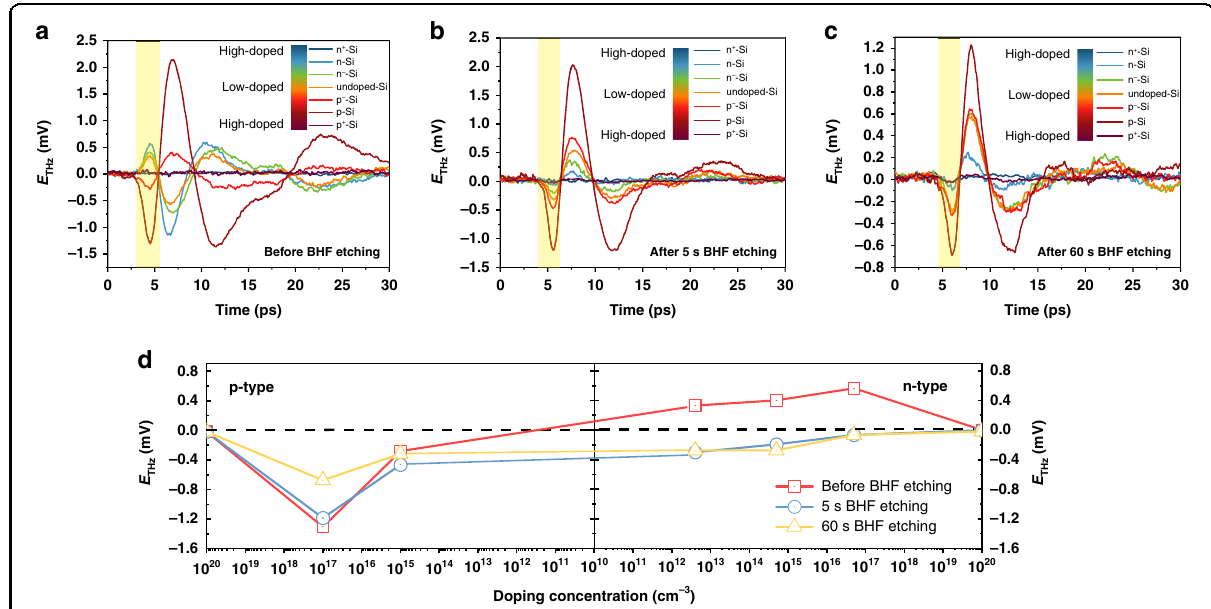
Fig. 2 The overall results of the THz emission from Si wafers in different conditions. THz emission spectra from Si wafers of different doping types and doping concentrations: ( a ) before BHF etching; ( b ) after 5 s BHF etching; ( c ) after 60 s BHF etching. d Doping concentration dependence on THz emission amplitude (where the fi rst peak is marked in yellow) ranges from high-doped p-type to high-doped n-type